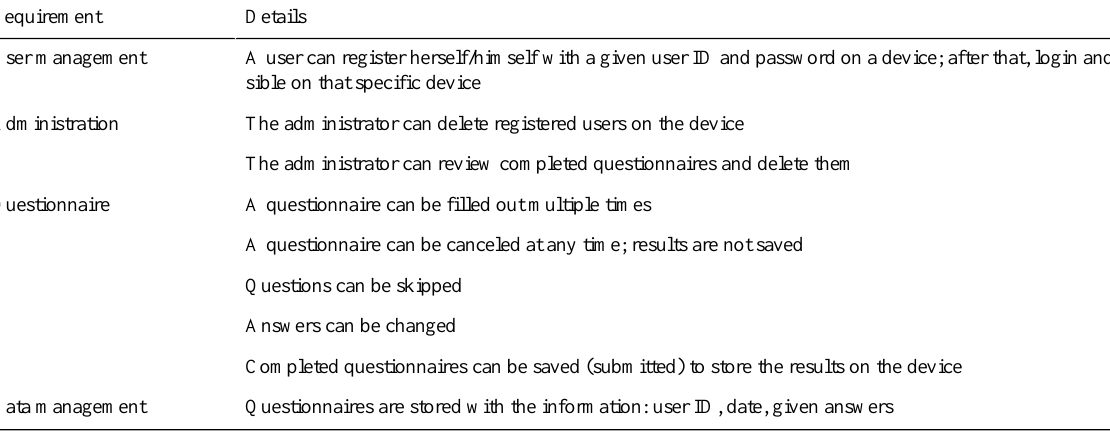
Table 1. Functional requirements for the prototype